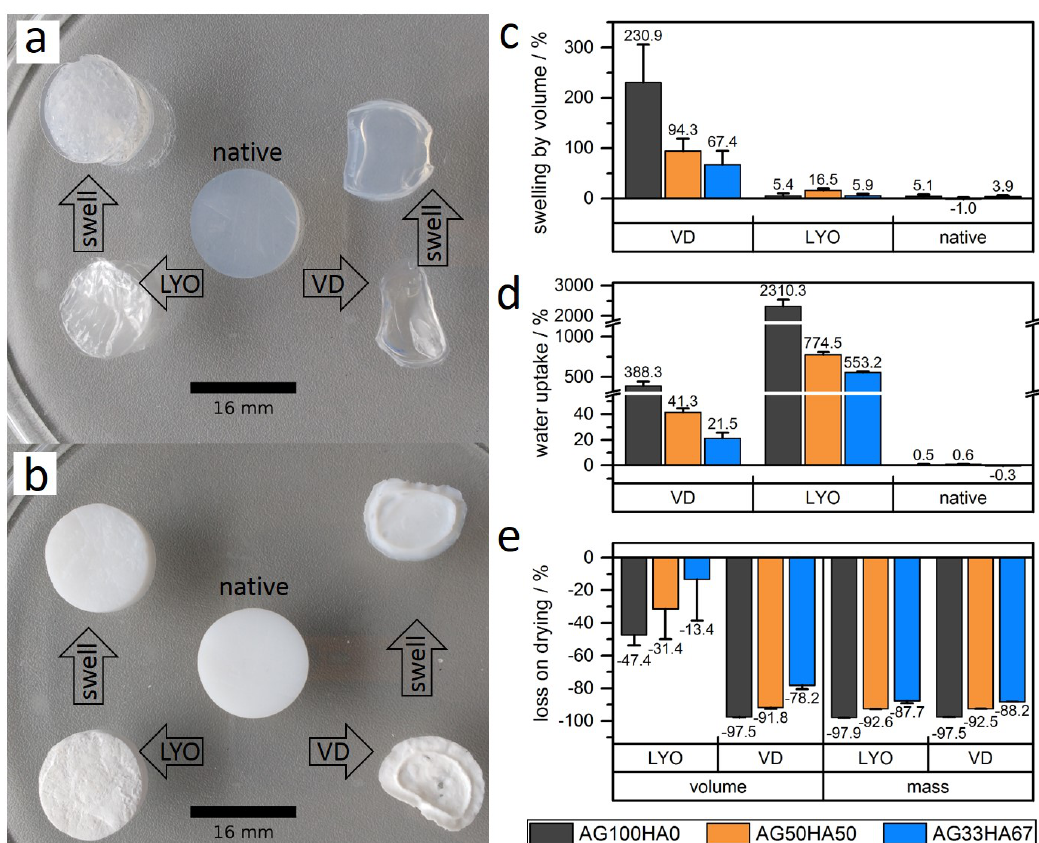
Figure 4. Images of ( a ) agarose hydrogel (AG100HA0) and ( b ) composite hydrogel (AG33HA67) in the native state, lyophilized (LYO), or vacuum dried (VD) and after reswelling of the dried gels. Comparison of ( c ) swelling, ( d ) water uptake, and ( e ) volume and mass loss for dried and native